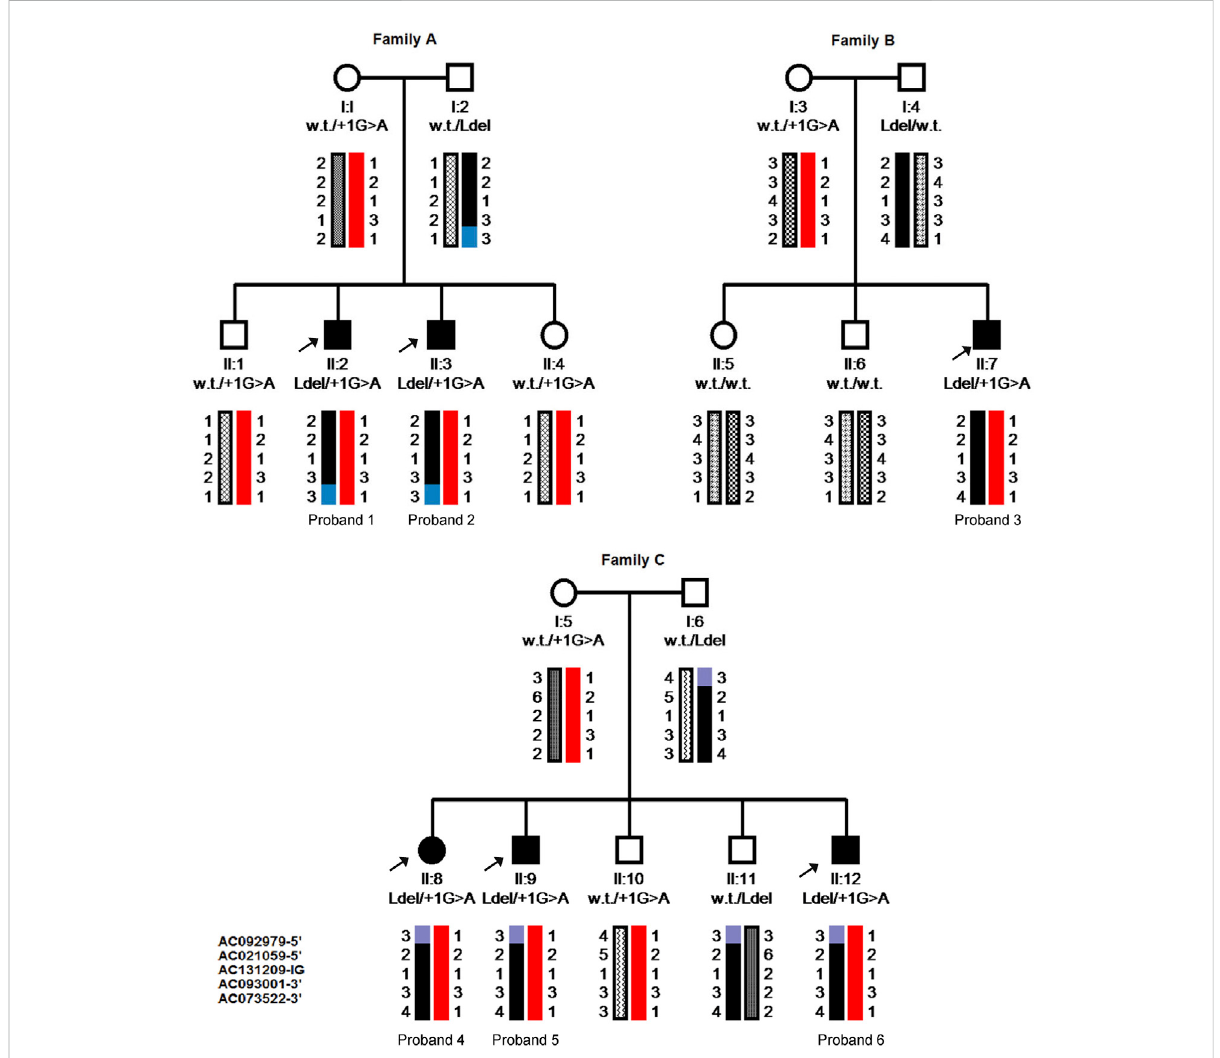
Pedigrees and Haplotype analysis of the six probands ’ families. Pedigrees include genotyping results shown as wild type (w.t.), large deletion (Ldel) or splicesite mutation(+1G > A), and the inherited chromosomes; each allele illustratedwith differentpatterns. Five polymorphic markers from clones located very close and on both sides of the HPS3 gene were used. From top to bottom: AC092979, AC021059059 (5 ′ -upstream of the HPS3 gene), AC131209 (Intra genic-IG), AC093001, AC073522 (3 ′ -downstream of the gene). Arrows pint to the affected member in each